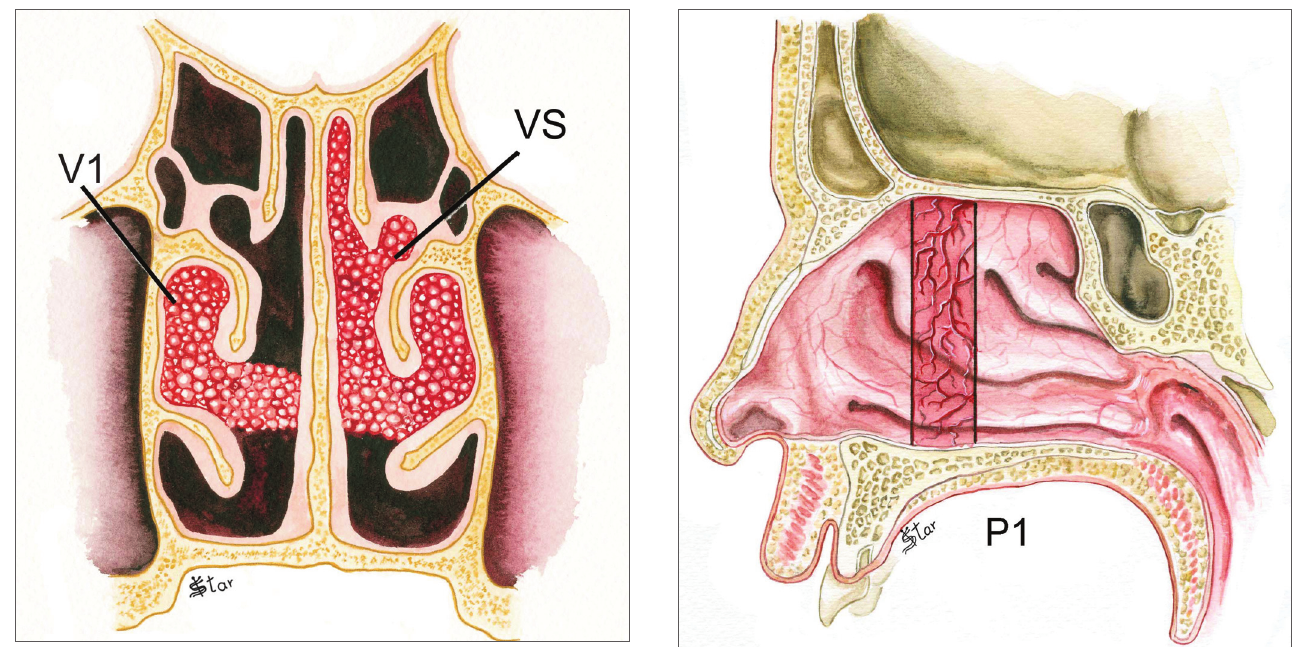
Figura 3. Estadiamento da PN no plano Vertical - V1 - pólipos restritos ao meato médio VS - pólipos com extensão superior ao meato médio